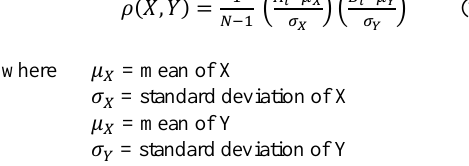
For every year in the time series, an average of the 24 models of RCP2.6 is calculated and has been used for the analyses, see Figure 5. For the sake of simplicity in the following, this new multi-model mean of SST is called the Models Yearly Mean (MYM).